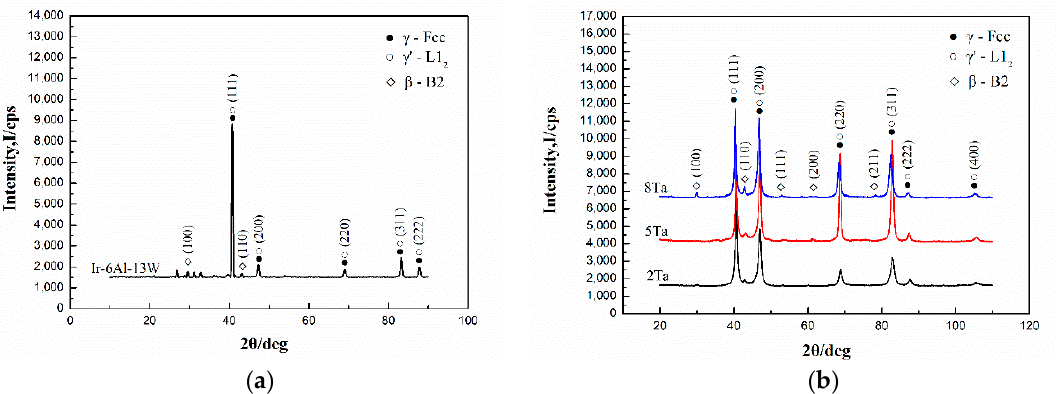
Figure 1. X-ray diffraction patterns of as-cast Ir-based alloys: ( a ) Ir–6Al–13W alloy; ( b ) Ir–6Al–13W– xTa alloys.